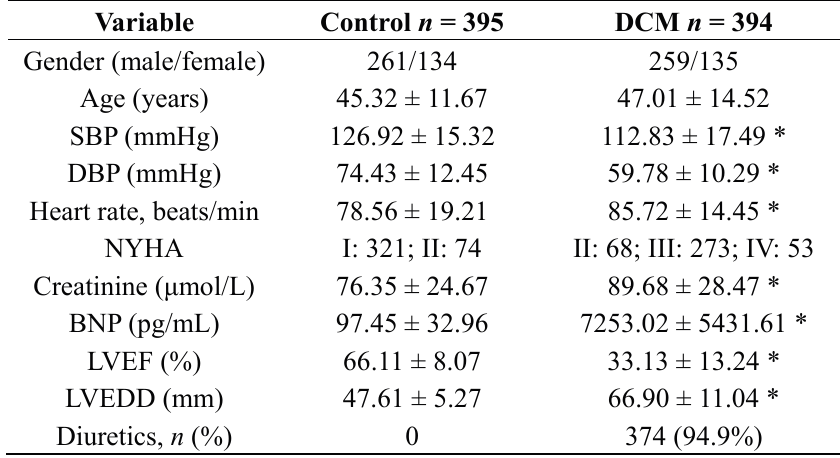
Table 1. Baseline characteristics of controls and dilated cardiomyopathy (DCM)